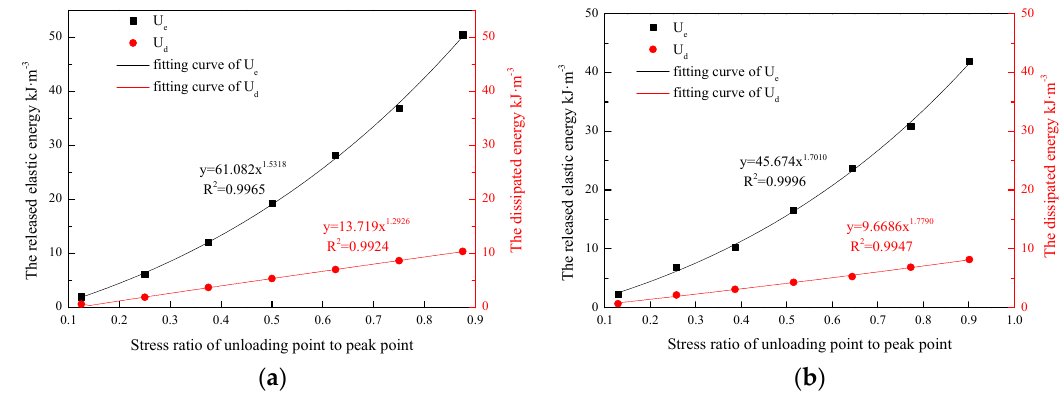
Figure 12. The typical fitting curves of U e and U d : ( a ) ZSM 1 -4; ( b ) XSM 2 -6. Table 3. Fitted values of the constants a,